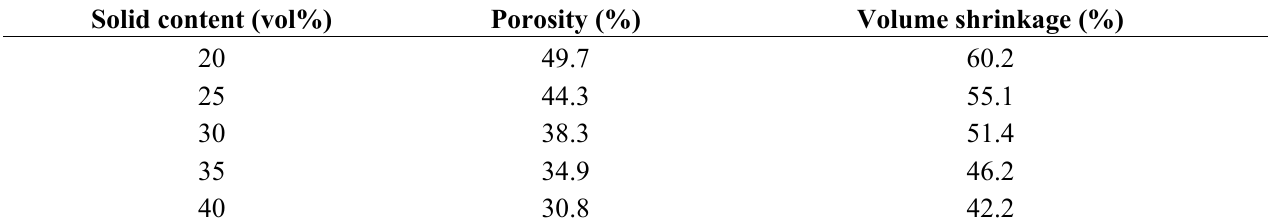
Table 1. Porosity and volume shrinkage of the porous Cu bodies as a function of the solid content in the slurry.